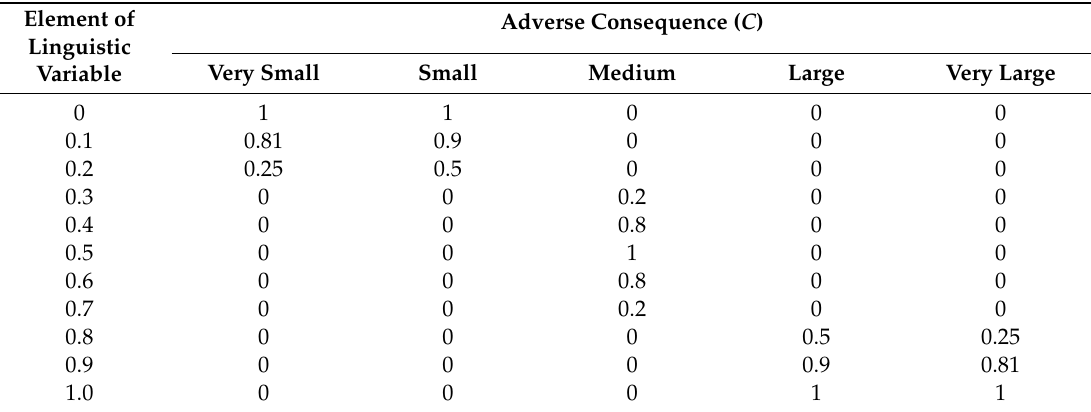
Table 3. Membership function for adverse consequence ( C ).